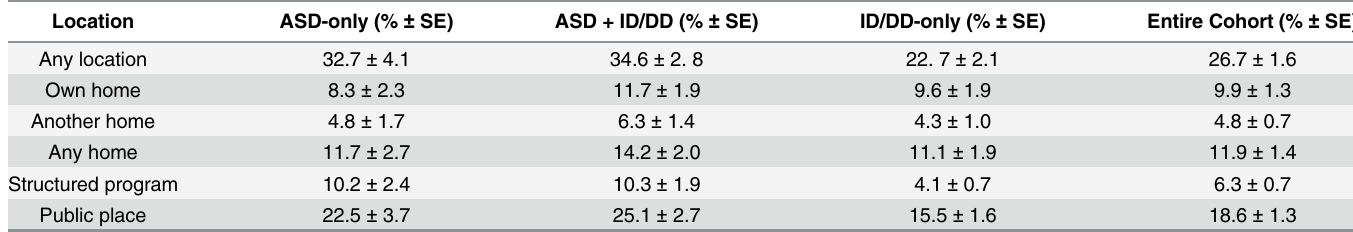
Table 2. Prevalence of Elopement by Location and Condition Group.